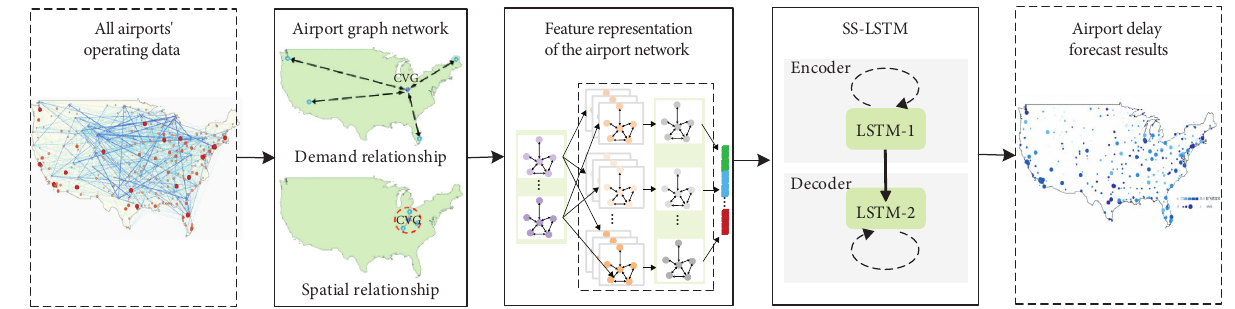
Figure 2: Architecture diagram of the DGLSTM airport delay prediction